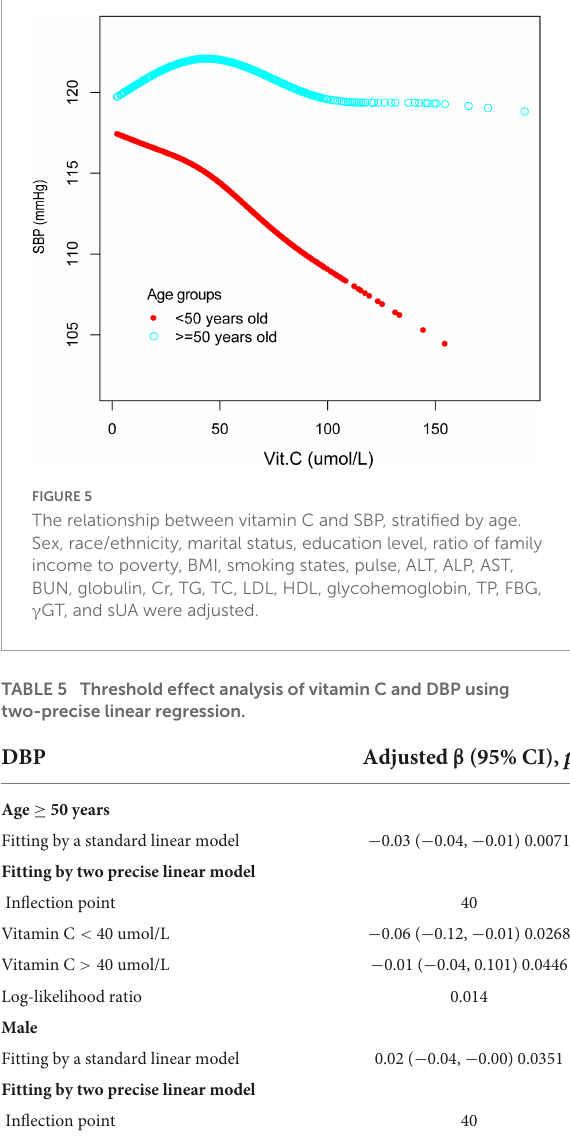
TABLE 4 Threshold effect analysis of vitamin C and SBP using two-precise linear regression.